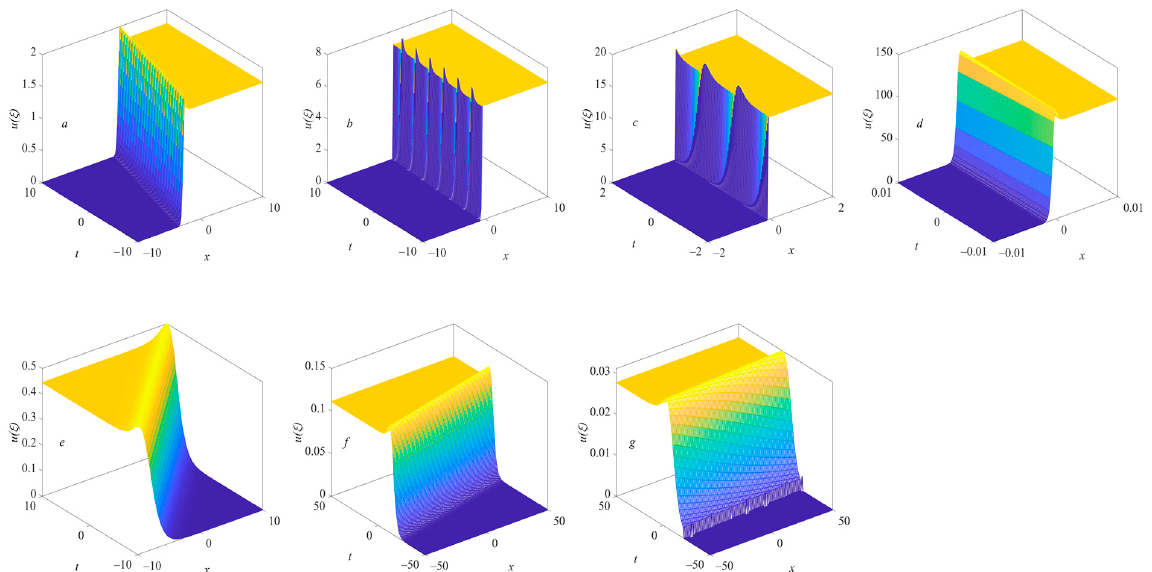
Figure 10. Evolution of solitary waves with n in u 10 n when k = 1, λ = − 1, ν = 1, ε = 1, r = − 1: ( a ) n = 1, ( b ) n = 2, ( c ) n = 4, ( d ) n = 8, ( e ) n = 1